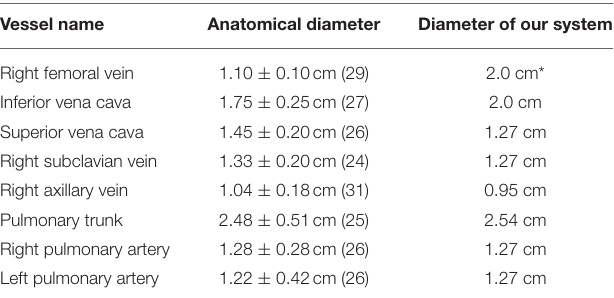
TABLE 3 | The internal diameter dimensions of anatomical vessels and our vascular